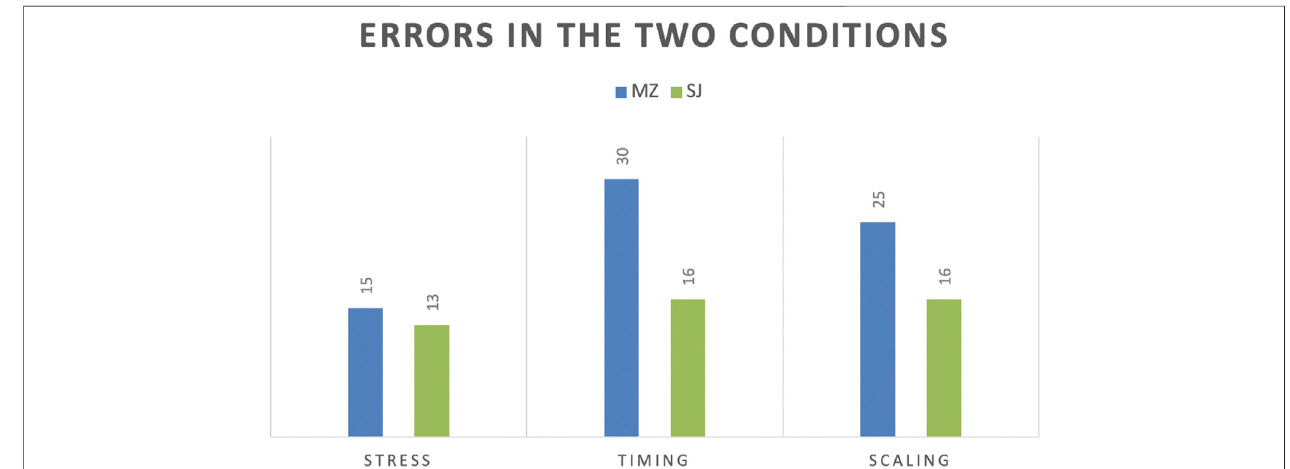
FIGURE 3 | Distribution of the errors made by students in the two